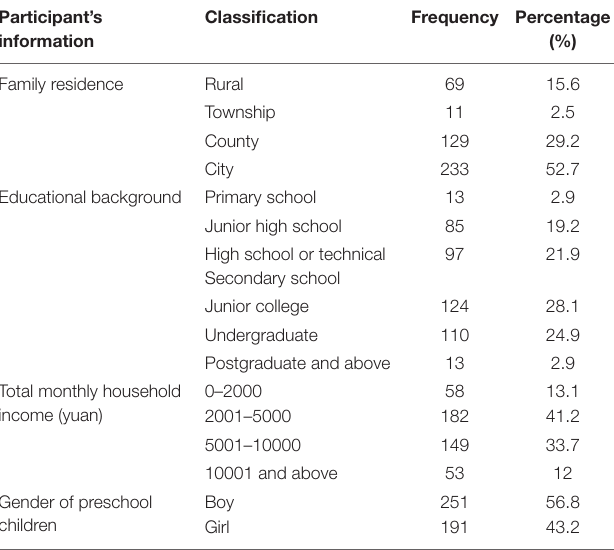
TABLE 3 | Basic participant information of Sample 1 in Study 4 ( n = 442).